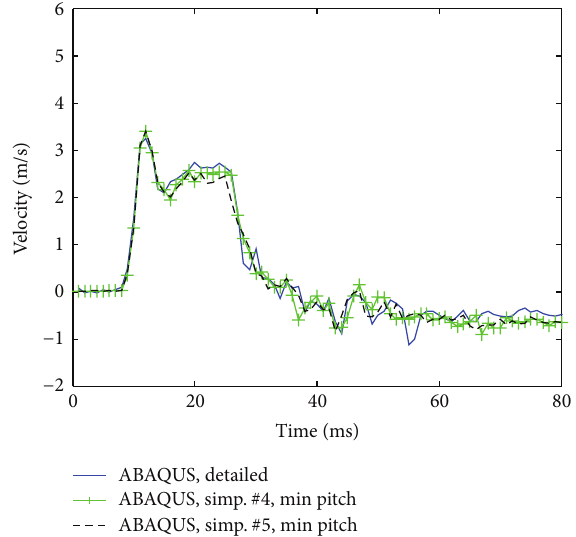
Figure 16: Velocity results for dynamic tension test, simplified model #1-2.